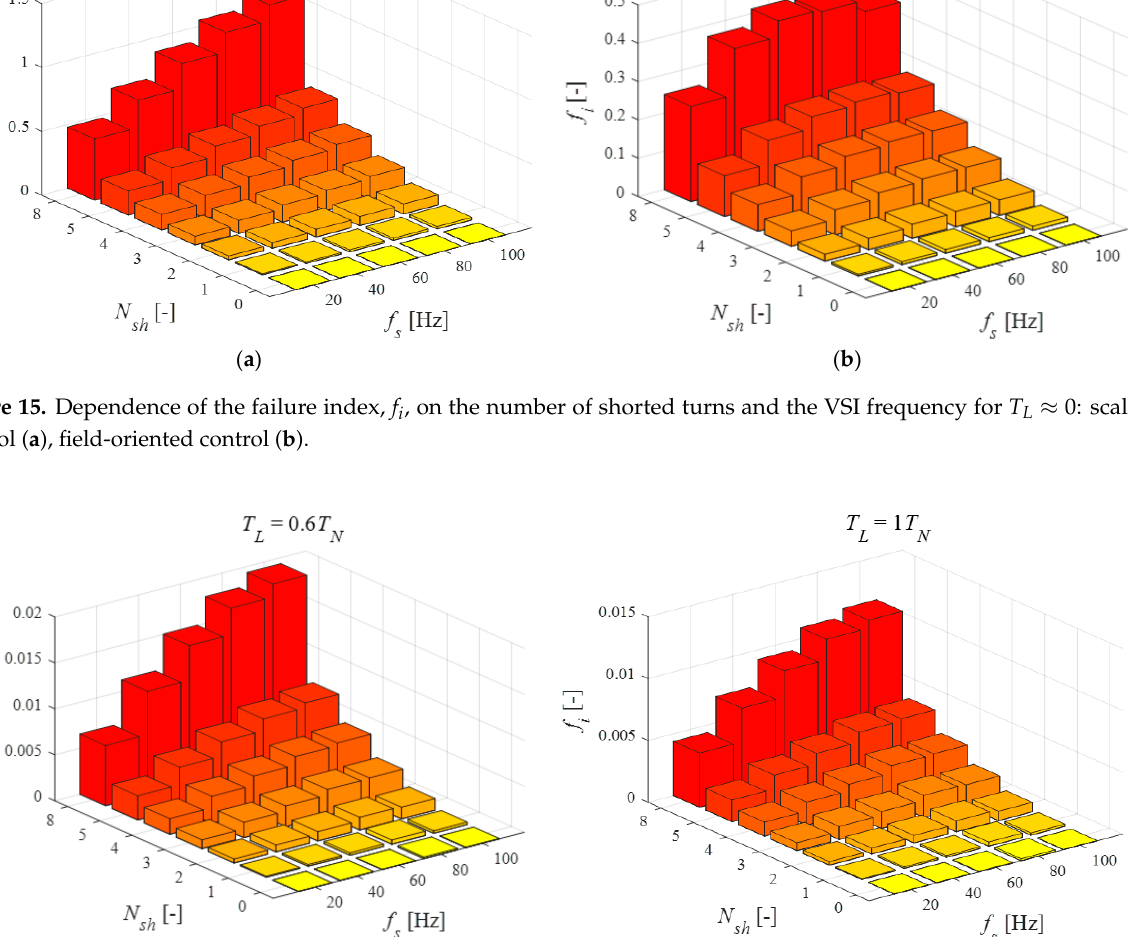
Figure 16. Dependence of the failure index in the field-oriented control, on the number of shorted turns and the voltage frequency for: T L = 0.6 T N ( a ), T L = T N ( b ).